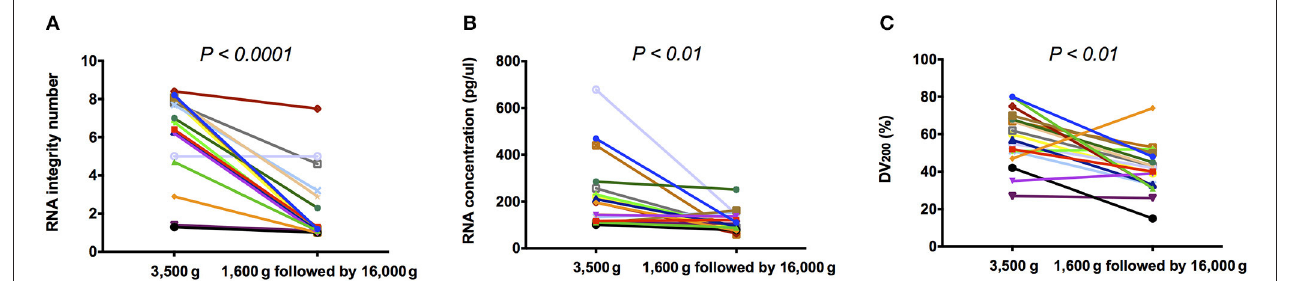
Frontiers in Genetics |